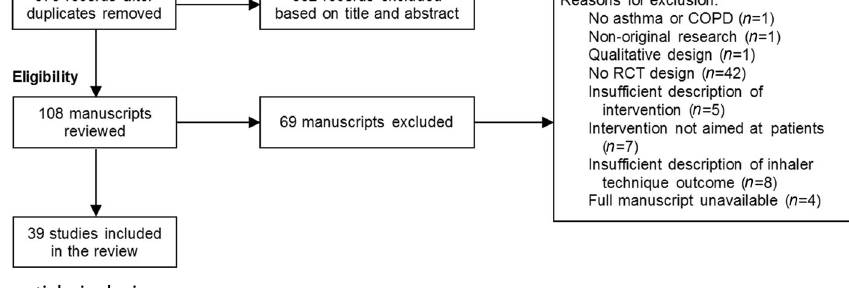
Fig. 1 Flow diagram on article inclusion